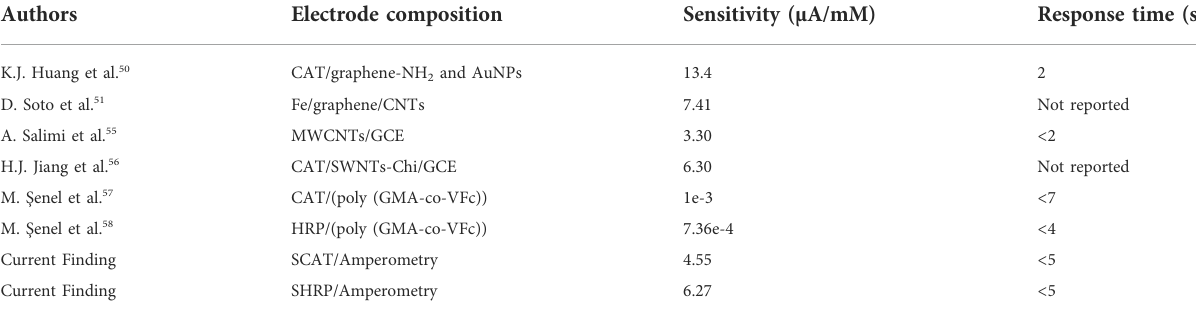
TABLE 3 Sensitivity of hydrogen-peroxide nanosensors.